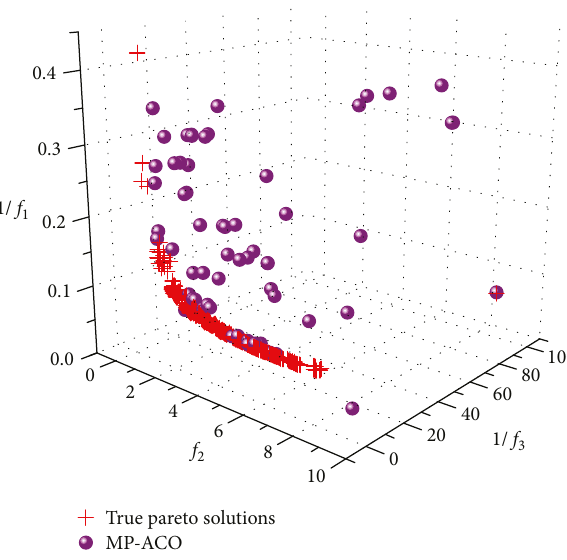
Figure 7: Plots of the true PSs and the fi nal PSs found by MPACO on the speci fi c